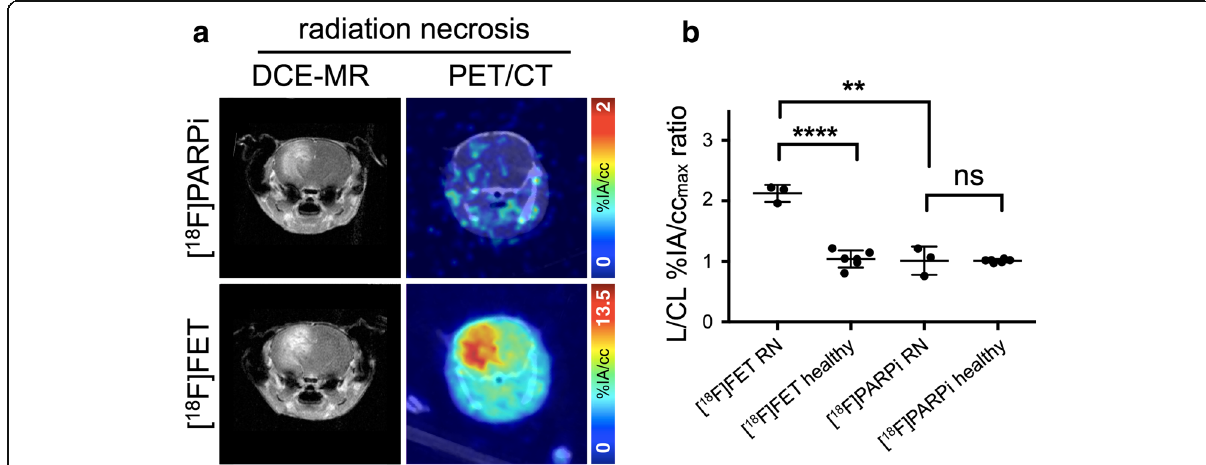
Fig. 4 PET imaging of experimental murine radiation necrosis. a (left column) DCE-MR and (right column) fused PET/CT transaxial slices of mice with experimental radiation necrosis, injected with (top row) [ 18 F]PARPi and (bottom row) [ 18 F]FET. b Lesioned-to-contralateral hemisphere %IA/ cc max ratios for mice in different groups. **Significant at p < 0.005; ****significant at p <